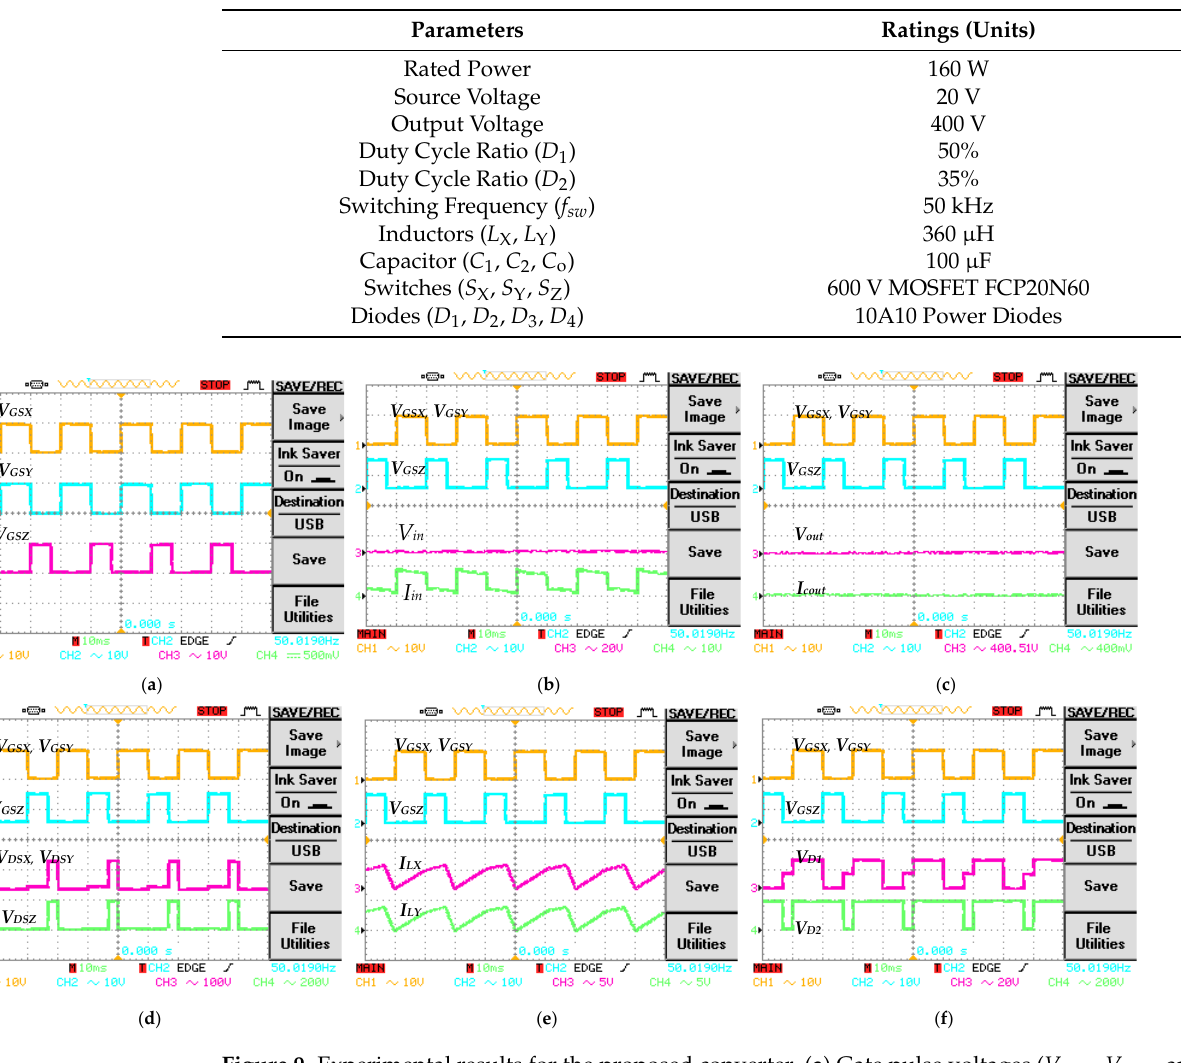
Figure 9. Experimental results for the proposed converter. ( a ) Gate pulse voltages ( V GS1 , V GS2 , and V GS3 ); ( b ) input voltage and input current ( V in and, I in ); ( c ) output voltage and output current ( V out and i cout ); ( d ) switch voltages ( V DSX , V DSY , and V DSZ ); ( e ) inductor currents ( I LX and I LY ); ( f ) diode voltages ( V D1 and V D2 ).